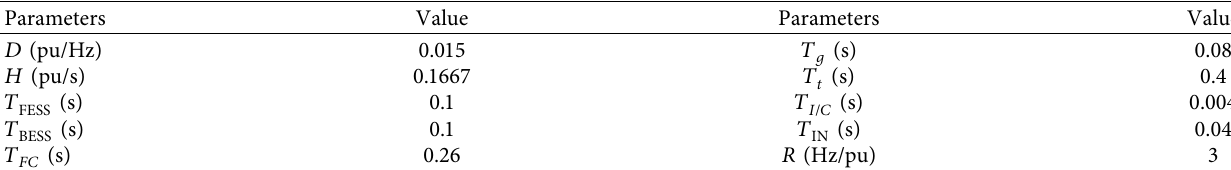
Table 1: Te electrical parameters of the MG shown in Figure 3.